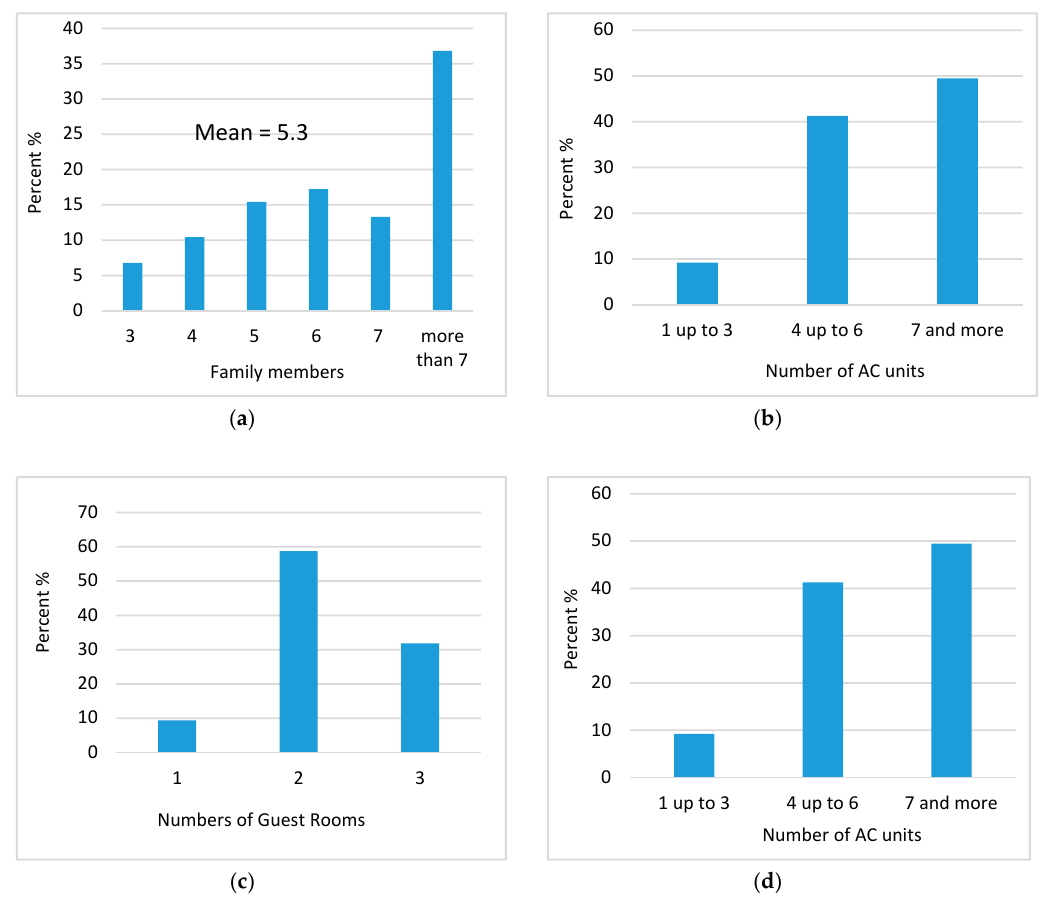
Figure 3. Demography of survey respondents: ( a ) Family members; ( b ) Number of bedrooms; ( c ) Number of guest rooms; ( d ) Number of AC units.